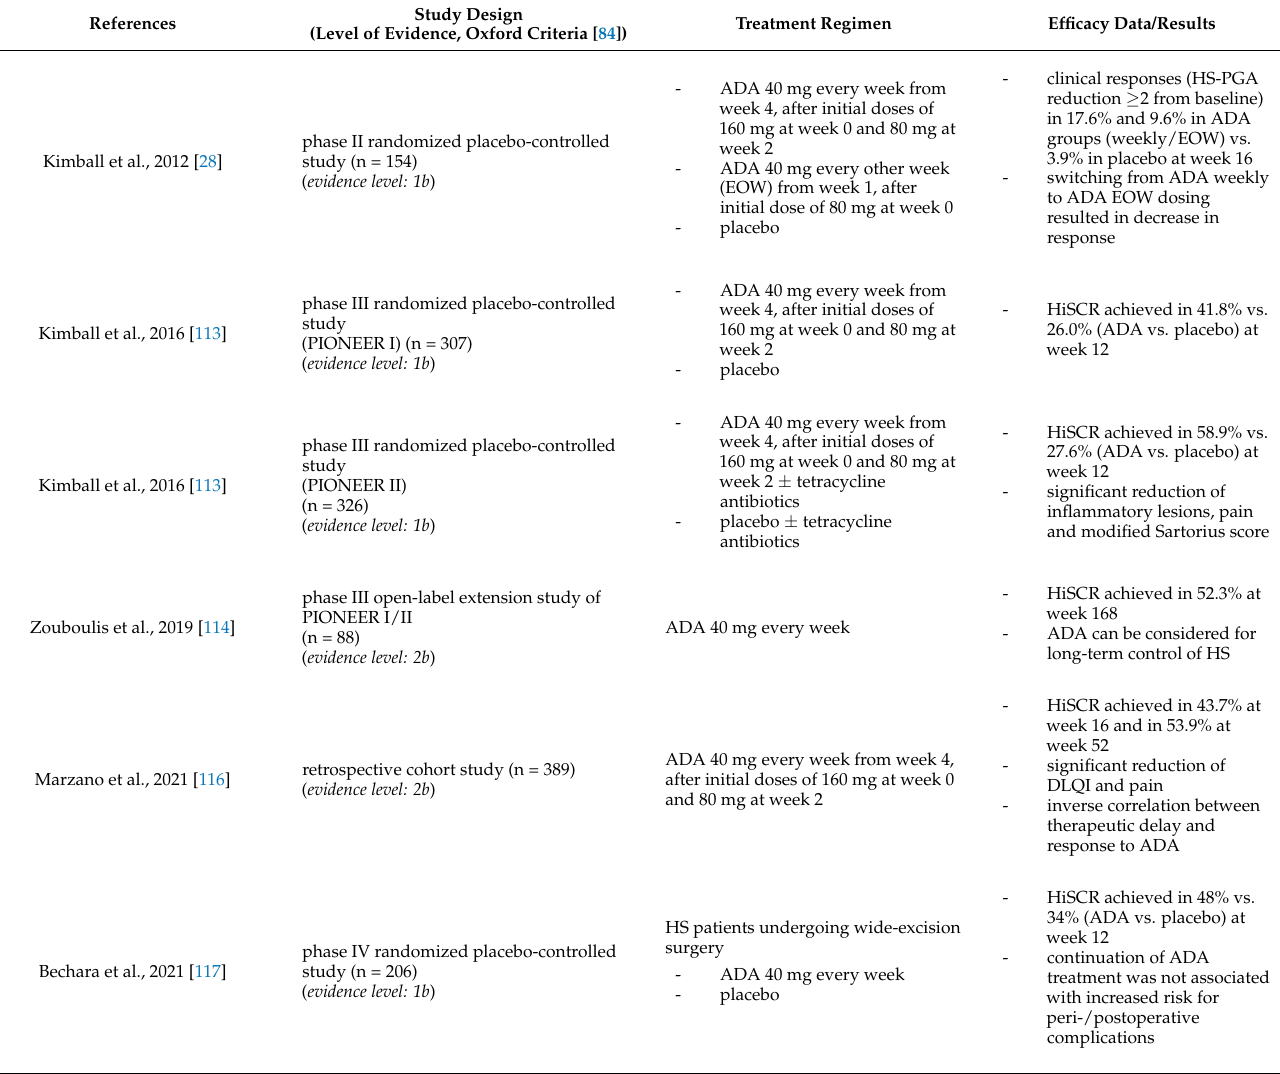
Table 4. Clinical studies evaluating adalimumab (ADA) for HS